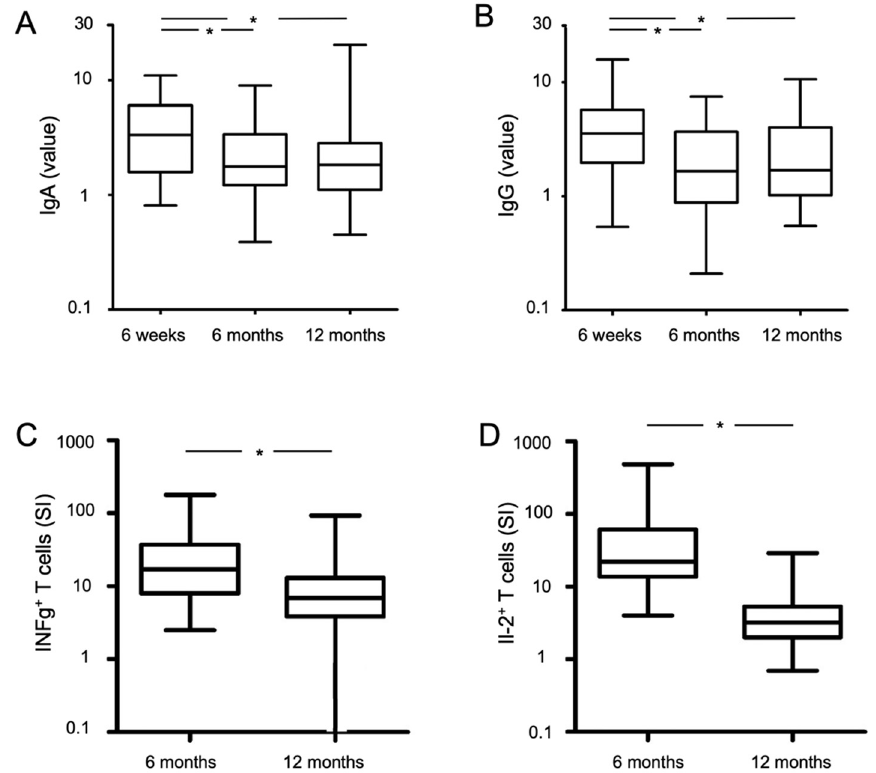
Figure 4. Course of IgA/IgG antibody level ( A , B ) and specific T-cells ( C , D ) over time. Black lines in boxplots represent median values. * p < 0.001 significant value. At 12-months measurement points, only non-vaccinated participants were considered.